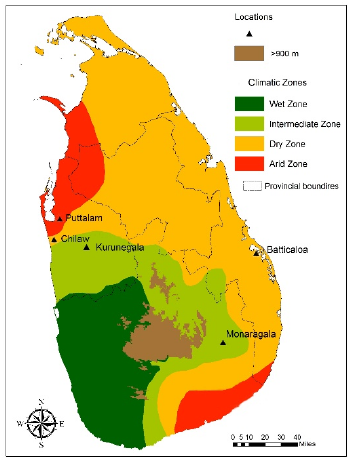
Figure 1. A map showing sampling sites.